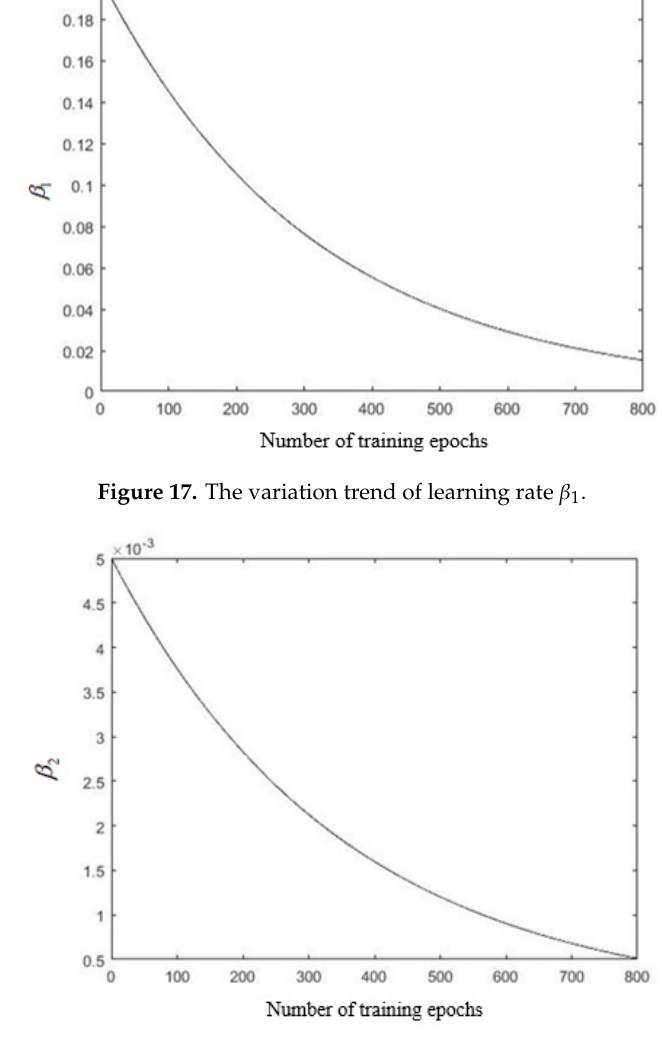
Figure 18. The variation trend of learning rate β 2 .